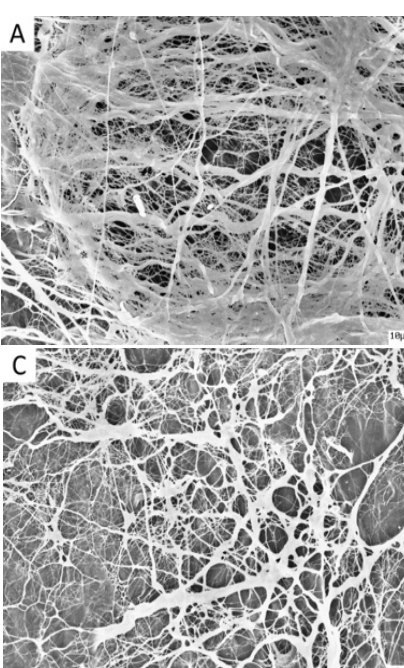
Figure 1. Photomicrographs of porcine pericardium matrices: ( A ) Group NP; ( B ) Group P8; ( C ) Group P12; and ( D ) Group P24. 1000× magnification.